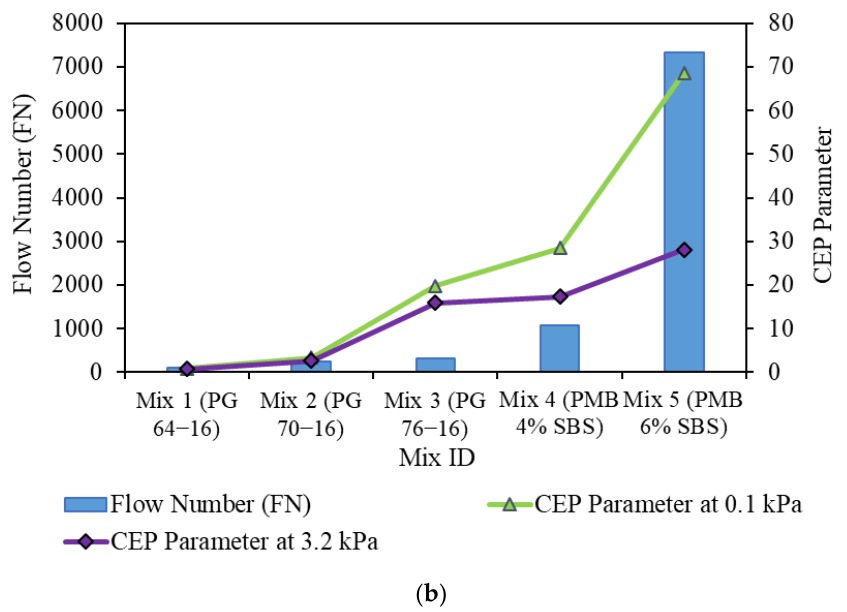
Figure 7. Relationship of Flow Number (FN) with ( a ) J nr and ( b ) CEP parameter at 64